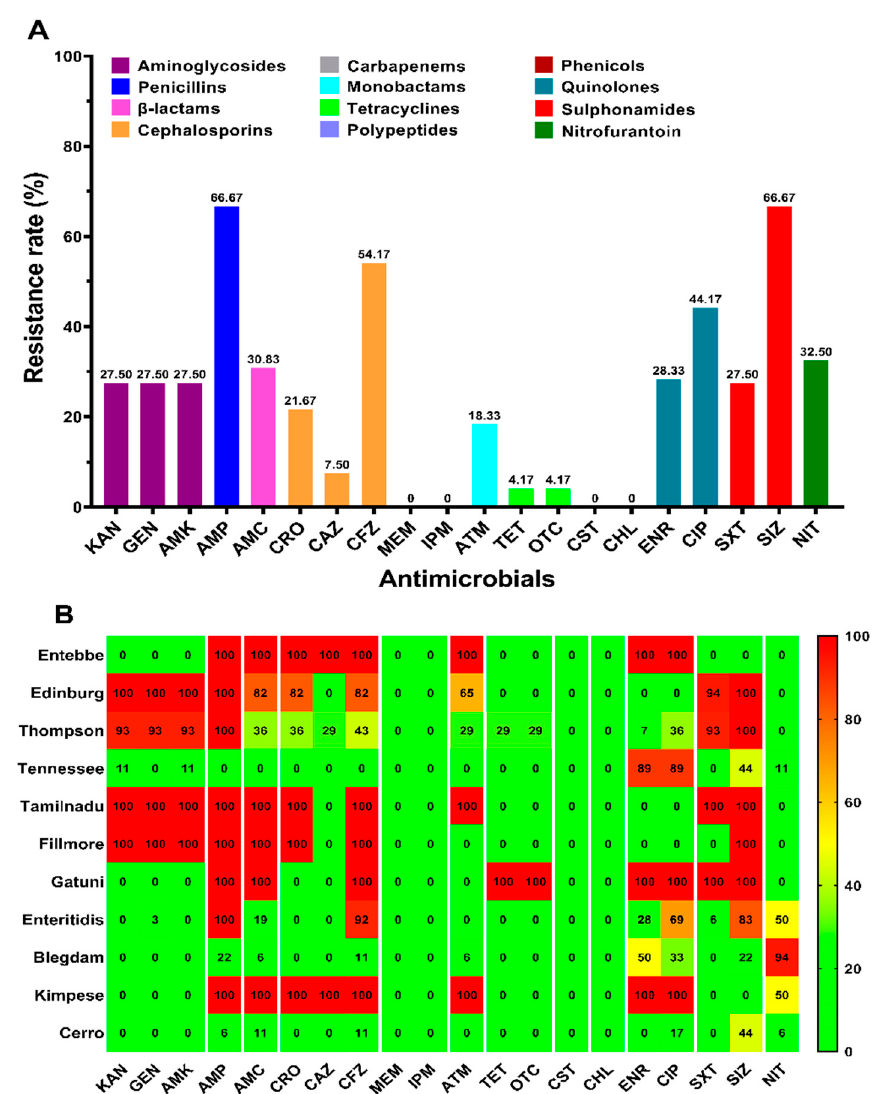
Figure 1. Prevalence of antimicrobial resistance among Salmonella isolates. The names of the antimicrobials are abbreviated as kanamycin (KAN), gentamicin (GEN), amikacin (AMK), ampicillin (AMP), amoxicillin-clavulanic acid (AMC), ceftriaxone (CRO), ceftazidime (CAZ), cefazolin (CFZ), meropenem (MEM), imipenem (IPM), aztreonam (ATM), tetracycline (TET), oxytetracycline (OTC), colistin (CST), chloramphenicol (CHL), enrofloxacin (ENR), ciprofloxacin (CIP), trimethoprim-sulfamethoxazole (SXT), sulfisoxazole (SIZ), and nitrofurantoin (NIT). ( A ) The prevalence of antimi- crobial resistance among the 120 Salmonella isolates against 20 antimicrobial agents of 12 categories. The same category of antimicrobial agents is represented by the same color; ( B ) the distribution of the average antimicrobial resistance (in percent) of various serovars towards 20 antimicrobial agents of 12categories. The color of individual cells varies with the percentage of antimicrobial resistance shown in the cells.